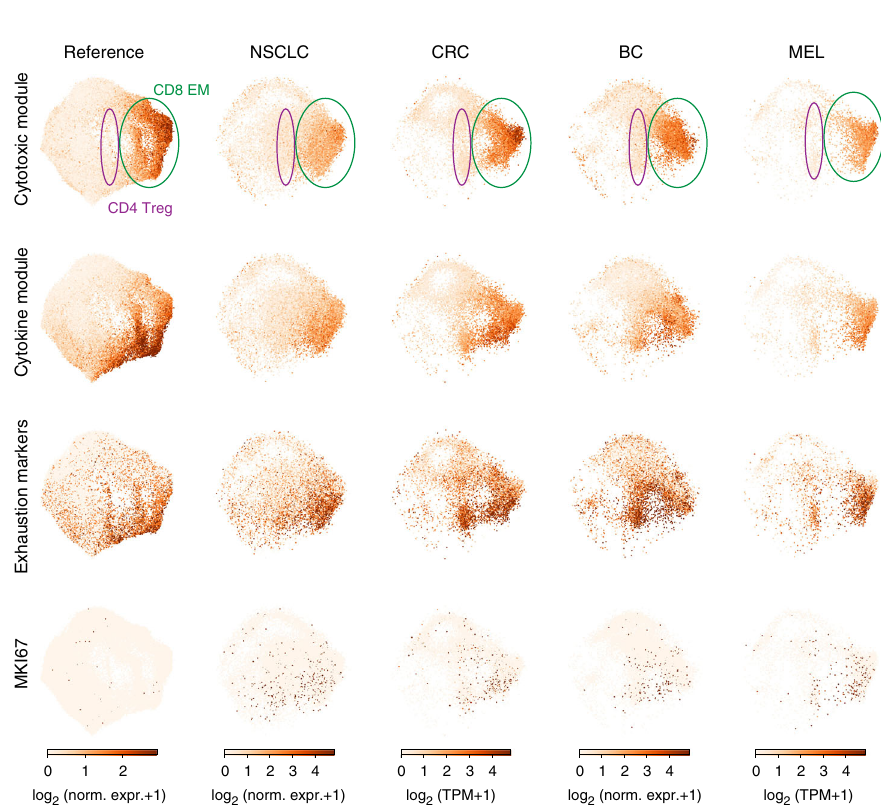
Fig. 7 Expression of functional modules and exhaustion markers on control and tumor associated-T cells. Individual cells in the UMAP embedding (far left column) shown for the entire healthy T cell reference dataset and UMAP projections (remaining four columns) for NSCLC, CRC, BC, and MEL tissue T cells. UMAP projections are colored by the average expression of the top 70 genes in the Cytotoxic module, the top 70 genes in the Cytokine module, the average expression of a set of exhaustion markers ( PDCD1 , CTLA4 , LAYN , LAG3 , TIM-3 , CD244 , and CD160 ), and expression of the proliferation marker MKI67 . Note that these expression values are normalized so that they can be quantitatively compared within each dataset (within each column), but not across